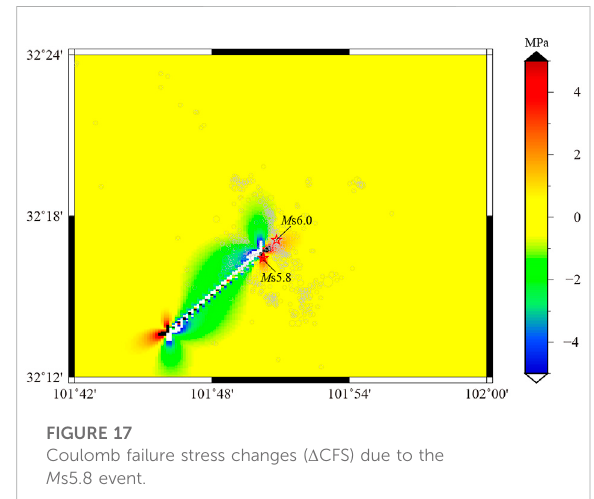
FIGURE 17 Coulomb failure stress changes ( Δ CFS) due to the M s5.8 event.